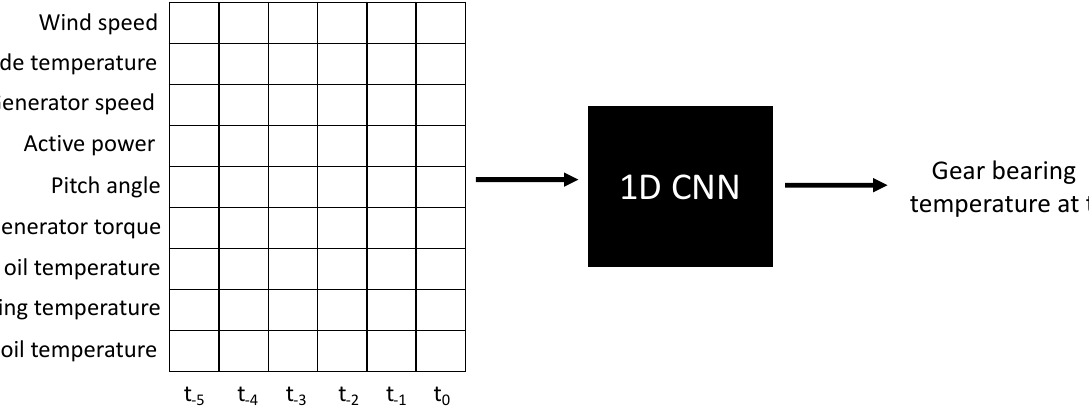
Figure 4. Architecture of the 1D CNN, including the input and output shapes of each layer.